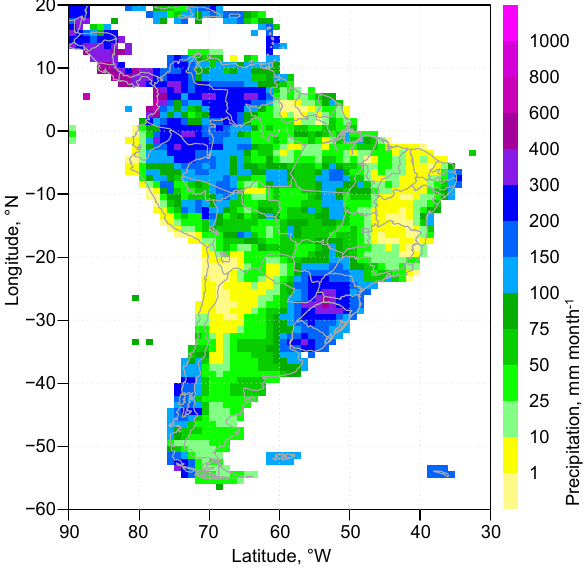
Figure 2. Columnar precipitable water anomaly for Septem- ber 2014 (based on the 1981–2010 average NCEP/NCAR reanal- ysis).